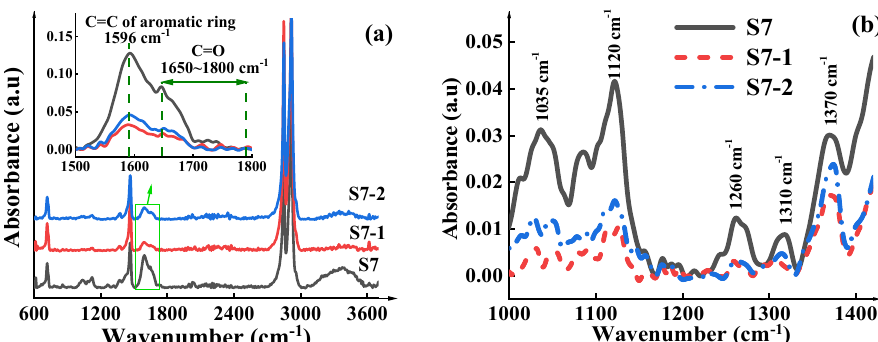
Figure 5. The FTIR spectra of the inner insulating layer for different aging modes. ( a ) FTIR spectrum ranging from 600 to 3650 cm − 1 . ( b ) Local enlarged FTIR spectrum ranging from 1000 to 1420 cm − 1 . In Figure 5a, it is observed that prominent absorption peaks at 1596, 1650, and 3370 cm − 1 exist in the inner insulating layers of S7. For S7-1 and S7-2, minor changes in these peaks in the range of 1700 to 1800 cm − 1 , compared to S7, indicate that thermal- oxidative aging hardly happens during the aging test. In addition, from the DSC measure- ment, it is found that there is no distinct displacement in S7-1 and S7-2 between the first heating and secondary heating melting curves after excluding the influence of thermal history. It is deduced that the backbone of XLPE is complete with little freed segments after the aging test. Therefore, the fluctuation in these absorption peaks is responsible for the additives left in the insulation at the production stage. After two aging tests with different modes, these absorption peaks decrease in varying degrees, indicating that volatilization or migration of polar compounds occurs during the aging process. Especially, a sharp absorption peak at 3640 cm − 1 is caused by the stretching vibration in the hydroxyl group of phenol ( v OH ). This is the characteristic peak of antioxidants. However, this peak is not obvious for S7. Since the antioxidants, DCP, and its byproduct all contain hydroxyl, these substances tend to form association complexes, so that the absorption peak in hydroxyl becomes wider and moves toward a lower wave number. After the aging tests, the decrease in volatile additive weakens the effect of association, resulting in the reappearance of the sharp absorption peak at 3640 cm − 1 . Furthermore, we enlarged locally the FTIR spectra in the range of 1000–1420 cm − 1 , as shown in Figure 5b. It is observed that there are obvious absorption peaks in 1035~1260 cm − 1 and 1310~1370 cm − 1 . The former is the stretching vibration in the carbon–oxygen bond of phenol ( v C-O ), and the latter is the in-plane deformation vibration in the hydroxyl group of phenol ( δ OH ). The molecular structure of antioxidants is mainly composed of phenol, as mentioned above. Therefore, these absorption peaks can be used as the characteristic absorption peak of antioxidants.